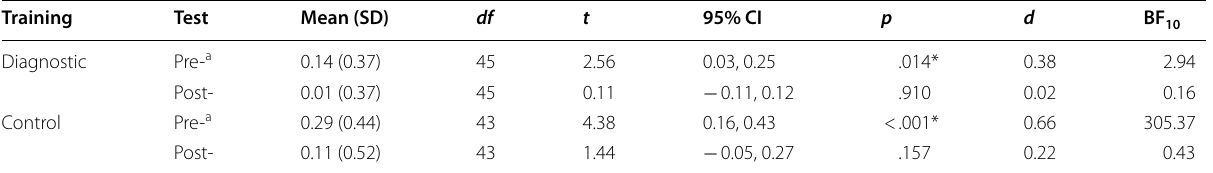
a A separate independent samples t -test confirmed that pre-training criterion did not differ between the two training conditions, t (88)